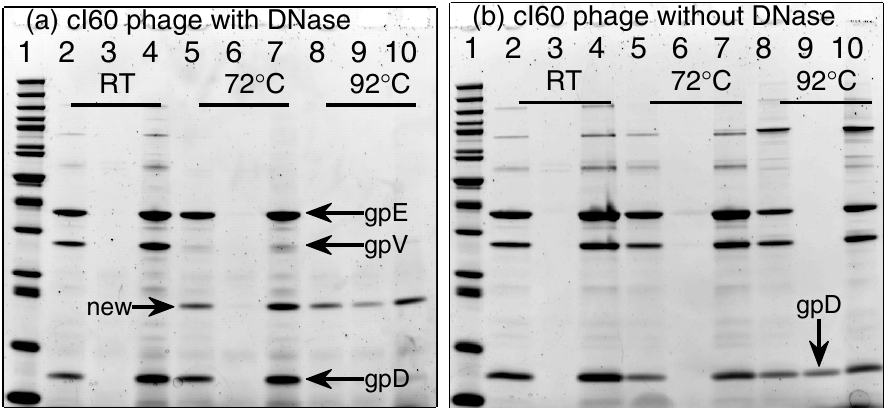
Figure 2. SDS-PAGE of intact cI60 phages incubated at room temperature (RT), 72, and 92 6 C. (a) With addition of DNase I. (b) Without the addition of DNase I. The three fractions incubated at each temperature are shown in the order of the as-is, supernatant, and pellet fractions (see text for details). NuPAGE 12% Bis-Tris gels (Invitrogen) were run at 120 V for 2 hours and 45 minutes in the MOPS SDS buffer. Lane # 1 is the PageRuler unstained protein ladder with 10 kDa to 200 kDa range.